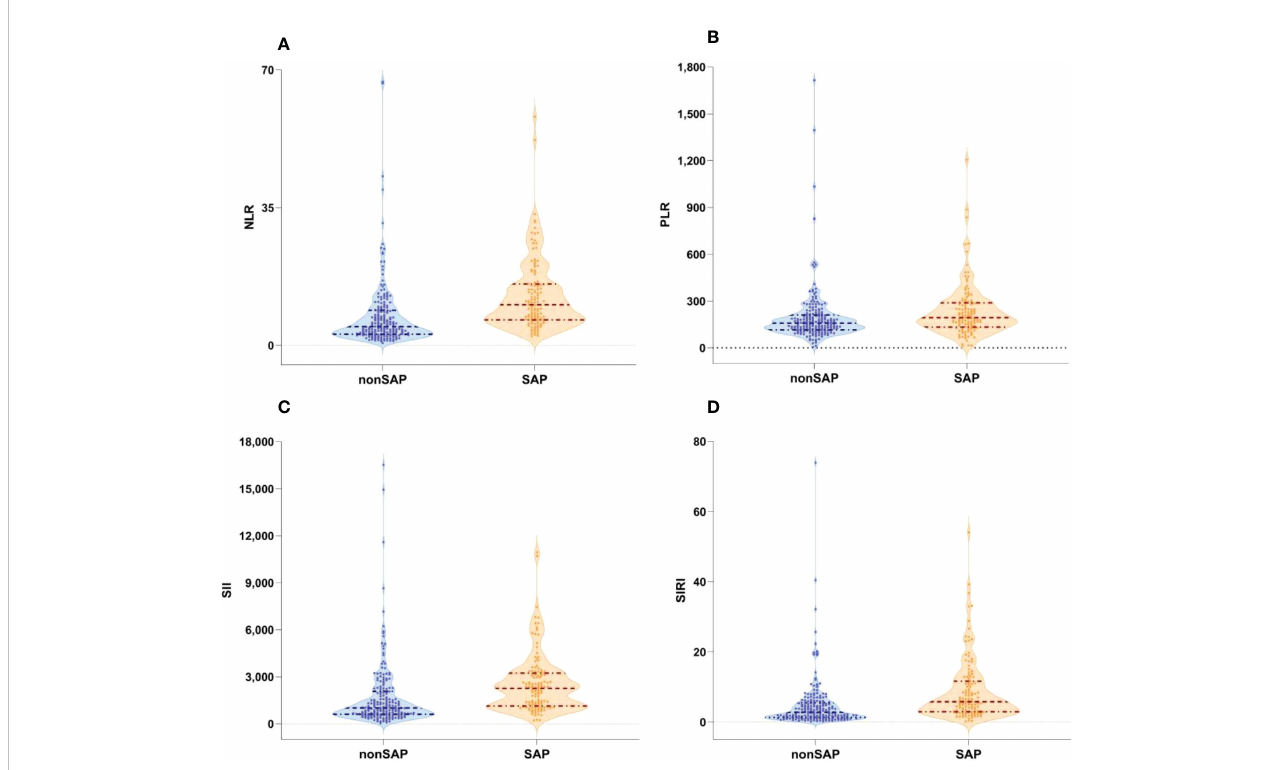
FIGURE 1 Boxplots of the NLR, PLR SII and SIRI showing the distribution in the non-SAP group (n=194) and SAP group (n=126). (A) The NLR of the SAP group was higher than that of the non-SAP group (<0.001). (B) The PLR of the SAP group was higher than that of the non-SAP group. (p=0.001). (C) The SII of the SAP group was higher than that of the non-SAP group. (<0.001). (D) The SIRI of the SAP group was higher than that of the non-SAP group(<0.001). NLR, neutrophil-to-lymphocyte ratio; SII, systemic immune-in fl ammation index; PLR, platelet-to-lymphocyte ratio; SIRI, systemic in fl ammation response index; SAP, stroke-associated pneumonia; non-SAP, non-stroke-associated pneumonia.